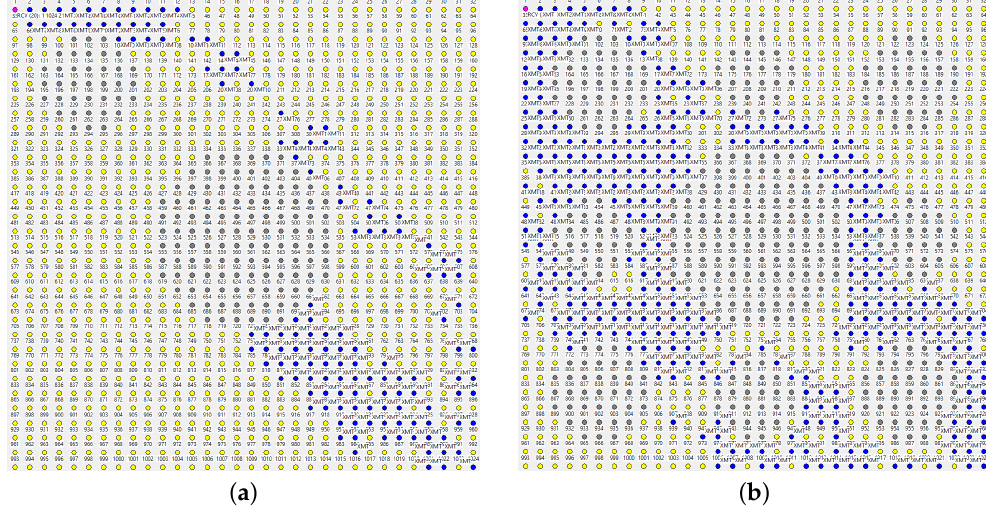
Figure 11. Paths obtained with A = 1 and fuzzy ACKs turned on ( R a = 2). ( a ) Under old beacon; ( b ) following a new